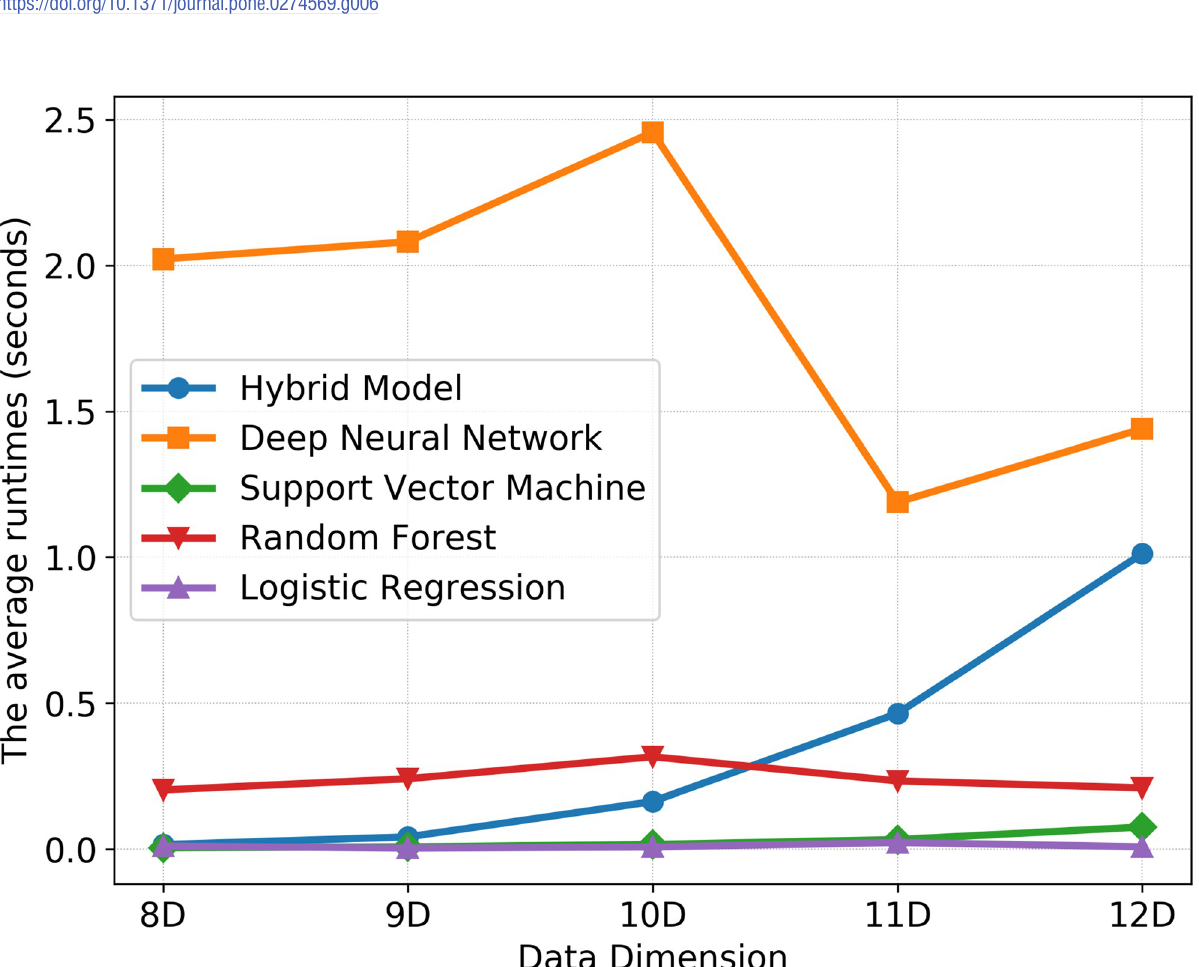
Fig 7. The running time efficiency. The comparison of the average running time of the examined methods for 150 experiments executed for each model and for N = 200 data points.